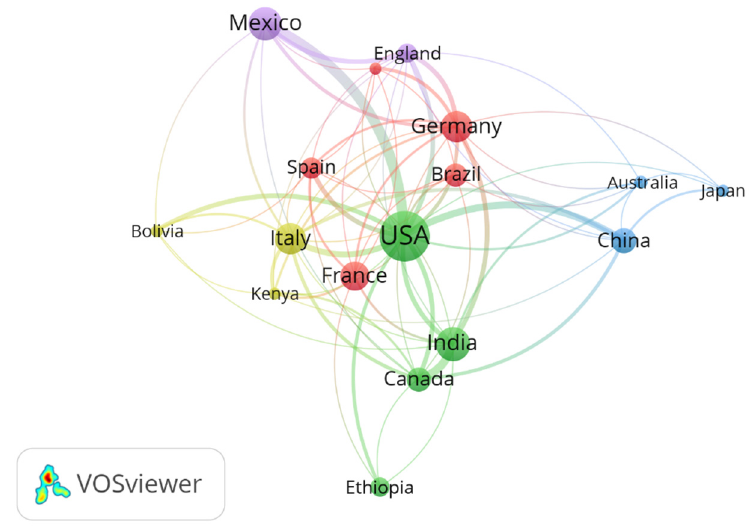
Figure 3. The collaboration network of countries about the agrobiodiversity and traditional knowledge.